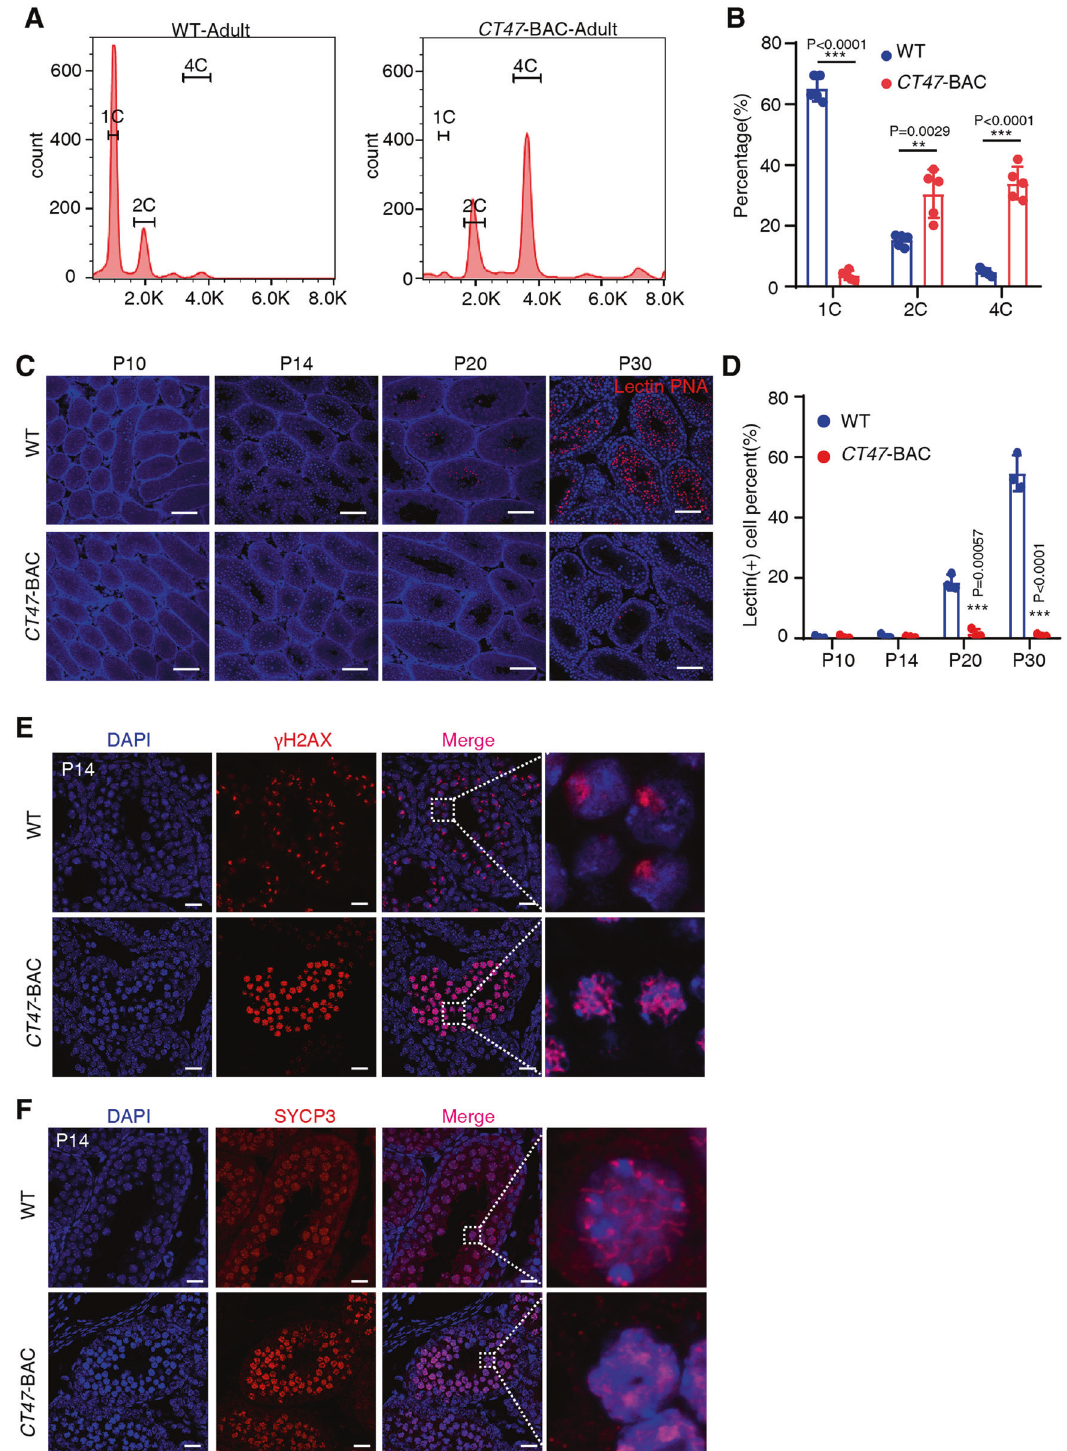
Fig. 3 Meiotic arrest during LZ/P spermatocyte transition in CT47 -BAC mice. A The proportion of different ploidy germ cells in WT and CT47 -BAC mice analyzed by FACS according to the DNA content in spermatogenesis. B Statistical results of different cell types in the FACS assay. 1 C DNA content: different steps of round and elongating spermatids and spermatozoa. 2 C DNA content: G1-phase spermatogonia and secondary spermatocytes. 4 C DNA content: various stages of primary spermatocytes and G2-phase spermatogonia. The results shown are the mean ± SD, n = 5 for each group. Student ’ s t test: *** p < 0.001. C Lectin PNA Alexa Fluor 568 (red) in testis at P10, P14, P20, P30 WT, and CT47 - BAC mice and scanned by TissueFAXS. D The proportion of lectin ( + ) cells was calculated. The results shown are the mean ± SD, n = 3 for each group. Student ’ s t test: *** p < 0.001, Scale bar = 40 μ m. E Immuno fl uorescence staining for γ -H2AX in the testes of P14 WT and CT47 -BAC mice. Scale bar = 40 μ m. Also see immuno fl uorescence staining for SYCP3 in Fig. 6C. F Immuno fl uorescence staining for SYCP3 in the testes of P14 WT and CT47 -BAC mice. Scale bar = 40 μ m. Also see immuno fl uorescence staining for SYCP3 in Fig. 6D.